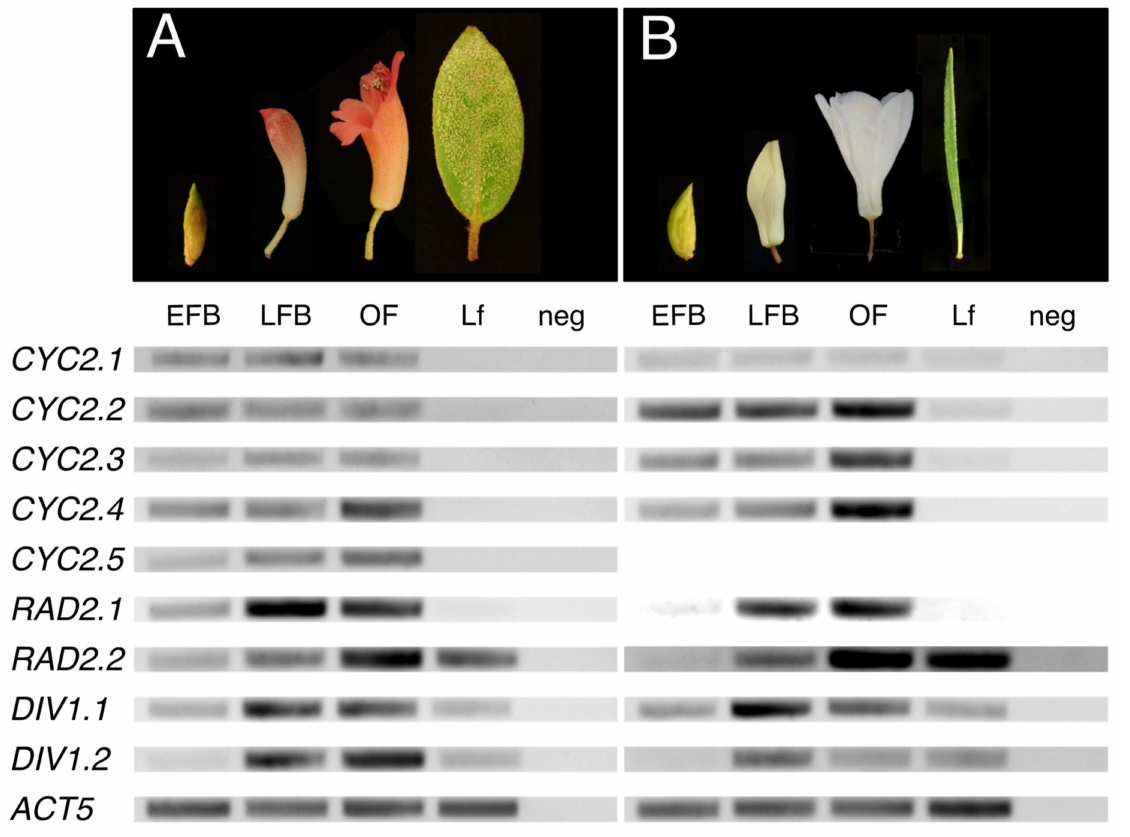
Figure 6. Gene expression of CYCLOIDEA ( CYC ), RADIALIS ( RAD ), and DIVARICATA ( DIV ) orthologs across flower development in two Rhododendron species with different floral symmetries. Gene expression shown by RT-PCR. Floral developmental stages sampled are early floral bud (EFB), late floral bud (LFB), and open flower (OF). Vegetative (Lf) and negative (neg) controls are also shown. ACTIN5 ( ACT5 ) is used as a reference gene. ( A ) Bilaterally symmetric R. beyerinckianum . ( B ) Radially symmetric R. taxifolium